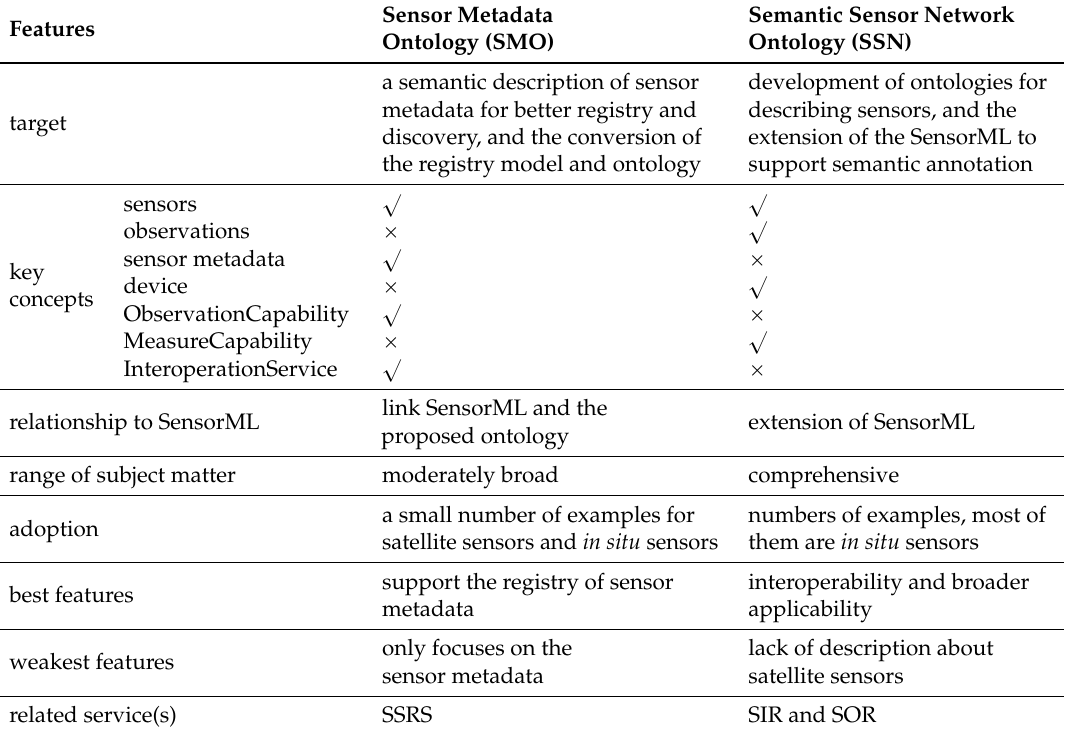
Table 1. Comparison between the SMO and SSN ontologies.